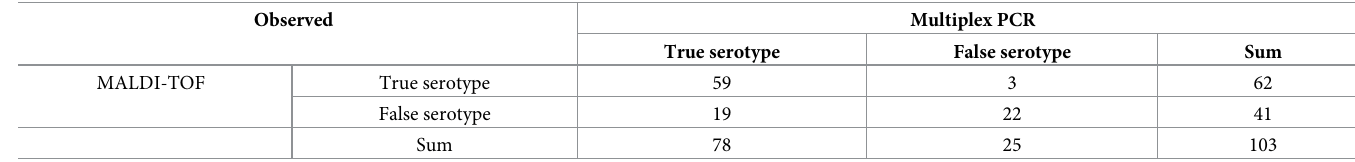
Table 2. Contingency table of identification frequencies to evaluate S . suis serotypes using the MALDI-TOF-MS analysis of this study compared to mPCR test. Observed Multiplex PCR True serotype False serotype Sum MALDI-TOF True serotype 59 3 62 False serotype 19 22 41 Sum 78 25